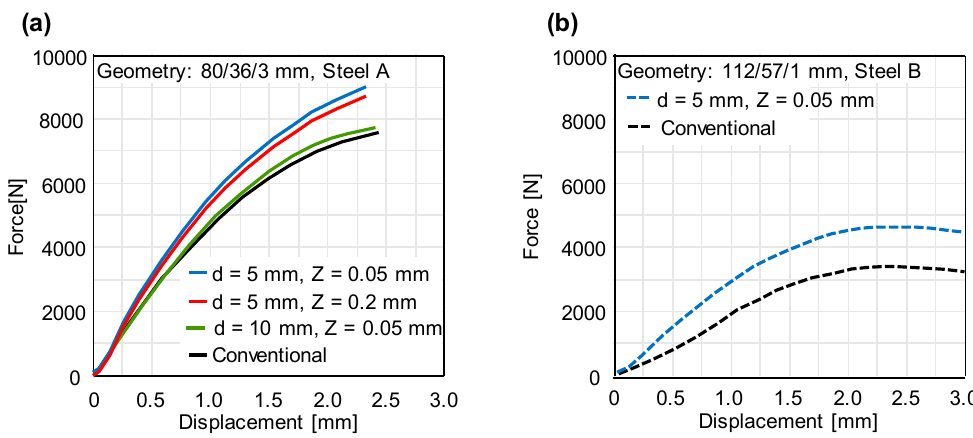
Figure 12. Characteristic force–displacement curves for conventional and incrementally formed disc springs from ( a ) steel A under varying process parameters ( b ) steel B.